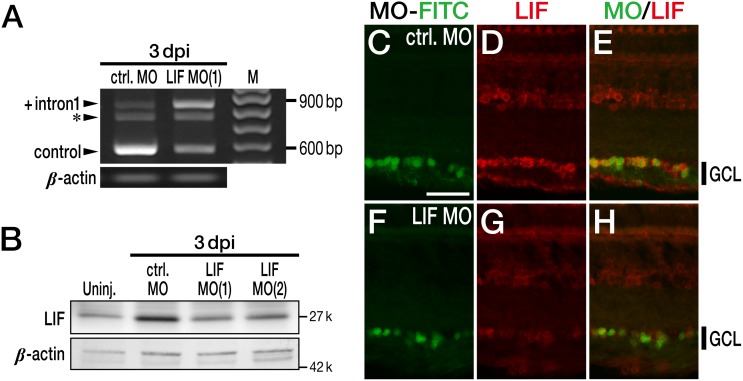
Knockdown of LIF in zebrafish RGCs after optic nerve injury.(A) Effects of LIF morpholino (MO) on the expression of LIF mRNA at 3 dpi. LIF MO(1) decreased the amount of control (i.e., normal) LIF mRNA product (control; 571 bp) and increased the amount of LIF with intron 1 (+intron1; 833 bp). The asterisk denotes a non-specific product. (B) Effects of LIF MO on the expression of LIF protein at 3 dpi. As expected, LIF MO(2), along with LIF MO(1), decreased the amount of LIF protein compared with the control (ctrl.) MO treatment. (C–H) Immunohistochemical analysis of LIF after MO treatment at 3 dpi. All MOs are labeled with FITC. LIF MO clearly attenuated the expression of LIF in the RGCs (F–H) compared with the treatment with control MO (C–E). The scale bar in (C) is 30 µm.